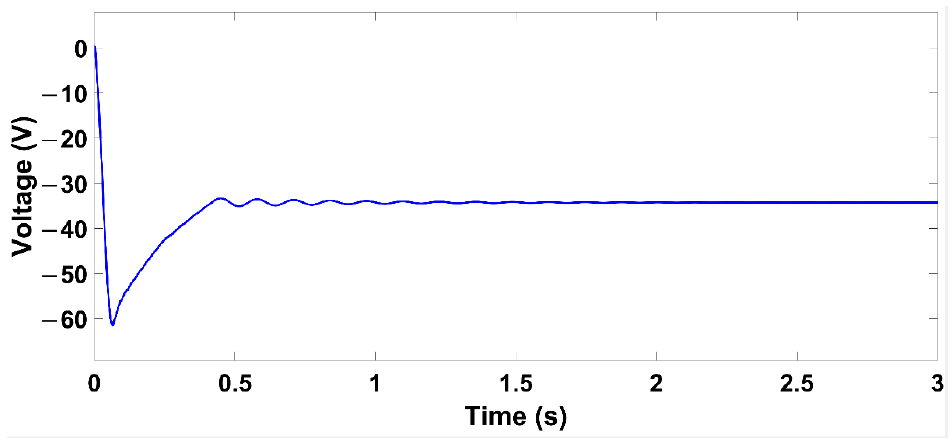
Figure 6. Output voltage across capacitor C 0 at D = 0.5 and V in = 3V. Voltages across different diodes and the MOSFET during the ON and OFF modes are shown in Figure 7. These voltages depict the behavior of the voltage stresses these devices experience. Moreover, we can also observe that during the ON mode, when the MOSFET is conducting, diodes D 1 , D 3 , D 4 , and D 7 are forward-biased, whereas diodes D 2 , D 5 , and D 6 are reverse-biased.